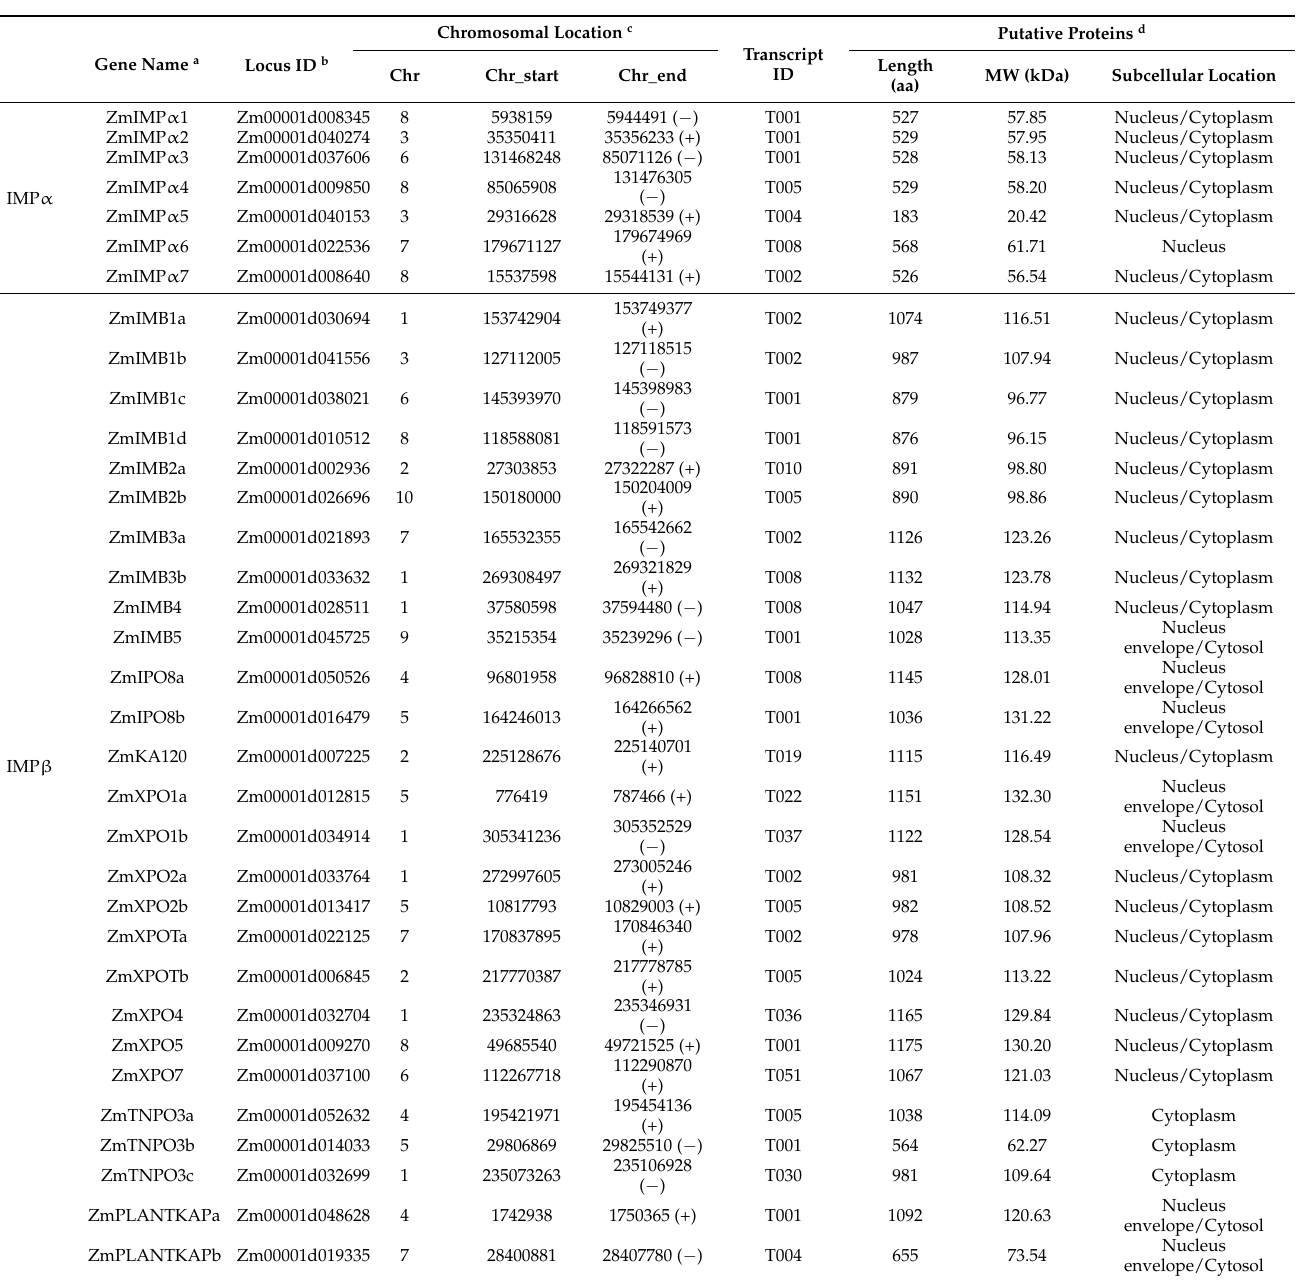
Table 1. List of putative Karyopherin gene family members in Zea mays